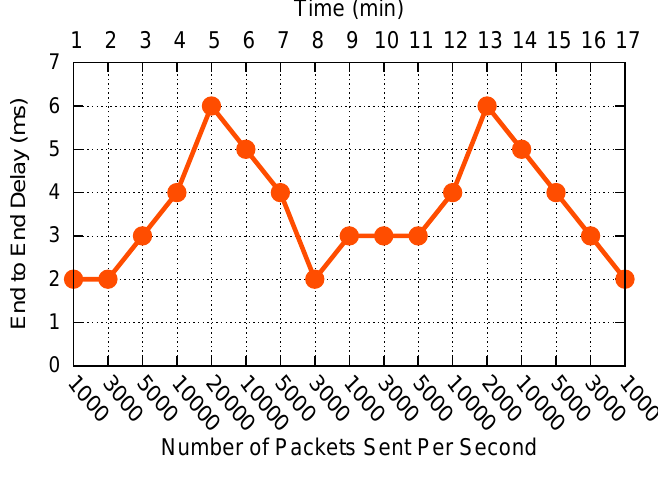
Figure 9. End-to-end